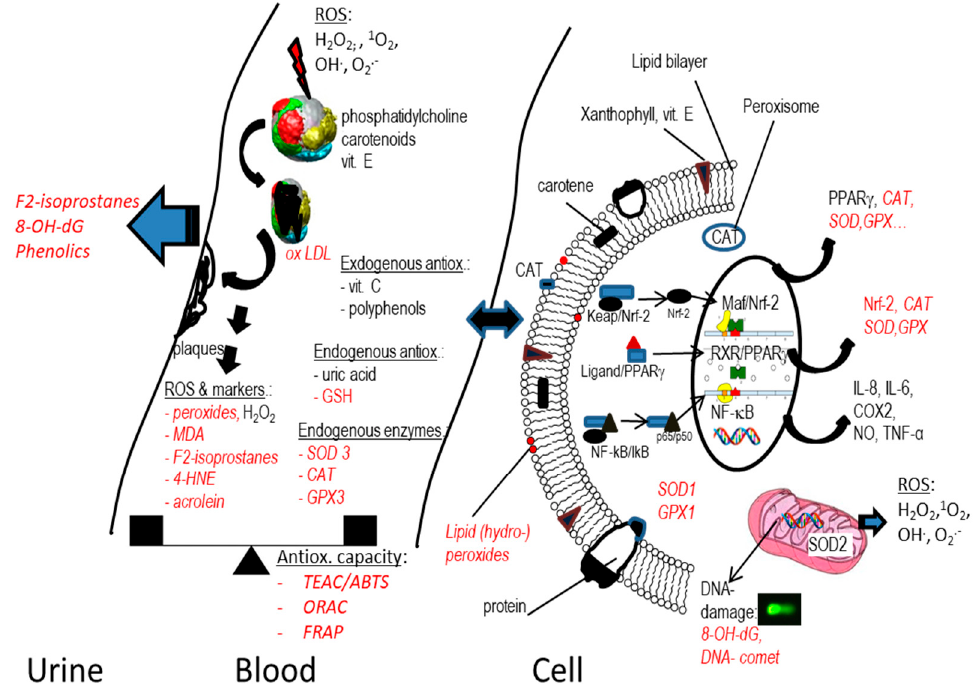
Figure 1. Overview of oxidative stress and employed markers related to carotenoid observational studies and intervention trials. Italic and red-printed items constitute frequently measured markers of oxidative stress and antioxidant capacity. For abbreviations, see the footnotes in Table 2.